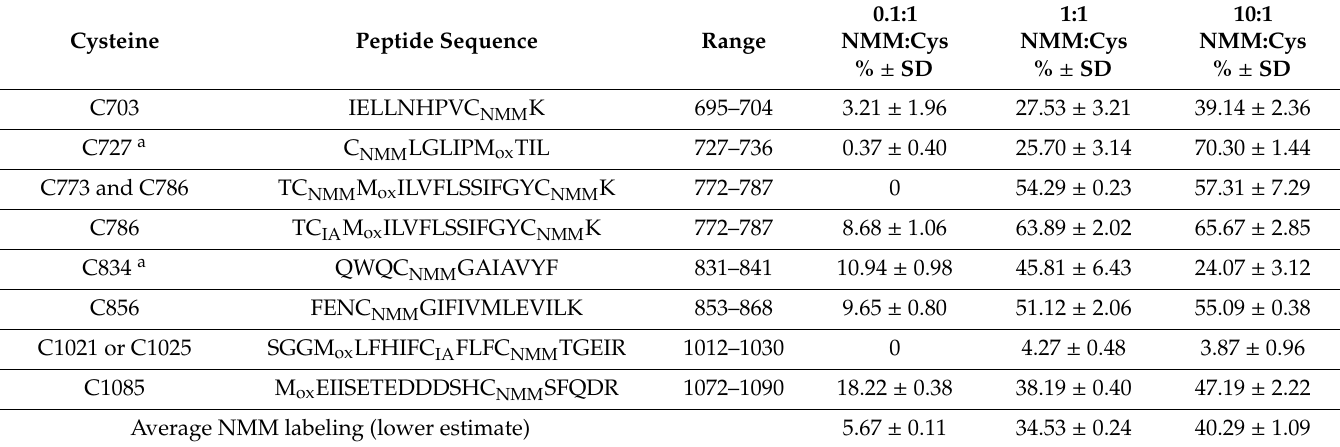
Cysteine Peptide Sequence